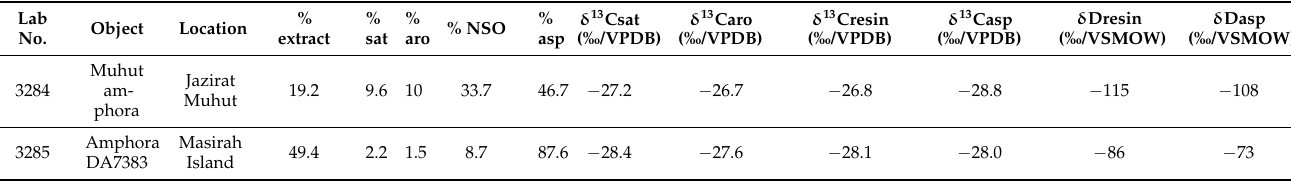
Table 1. Gross composition and isotopic data. Significance of abbreviations: % extract = % extractable organic matter with dichloromethane (%/weight of sample), sat = saturated hydrocarbons, aro = aromatic hydrocarbons, NSO = resins, asp =